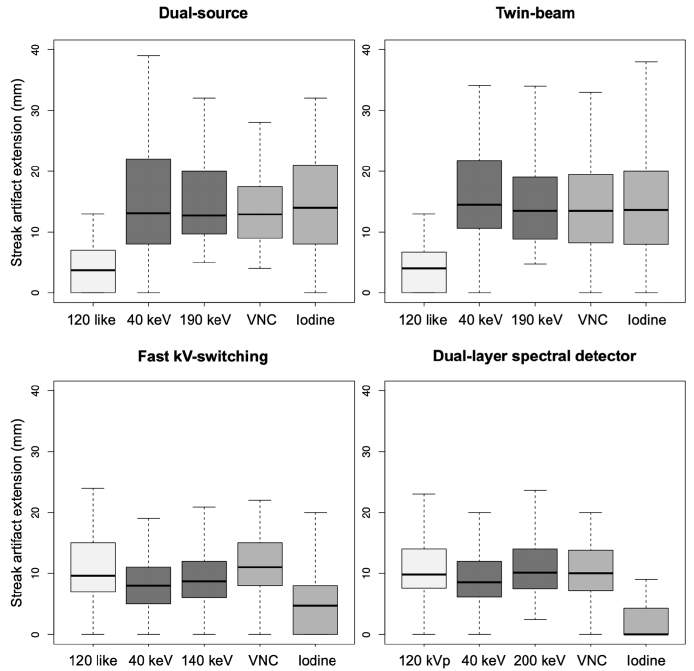
Figure 3. Depth of extension of visceral-motion-related artifacts into the liver parenchyma measured in axial 120-kVp(-like), low- and high-keV, VNC, and iodine images acquired on a dual-source, twin-beam, fast kV-switching, and dual-layer spectral detector CT scanner. Table 2. Quantitative measurements of visceral-motion-related artifacts on the liver in 120-kVp(- like), low- and high-keV, VNC, and iodine images acquired on a dual-source, twin-beam, fast kV- switching, and dual-layer spectral detector DECT scanner. ROImax (regions of interest measure- ment in the most visible area and on the low-keV bright area of the artifact). ROImin (regions of interest measurement in the most visible area and on the low-keV dark area of the artifact). ROIref (regions of interest measurement in neighboring, unaffected liver parenchyma). Dual-source